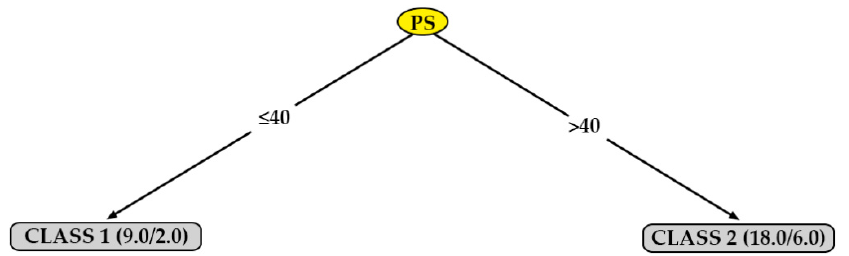
Figure 9. Decision tree for surface roughness measured in the direction parallel to the extrusion path on printed specimens in the XZ orientation (R a,0,XZ ).